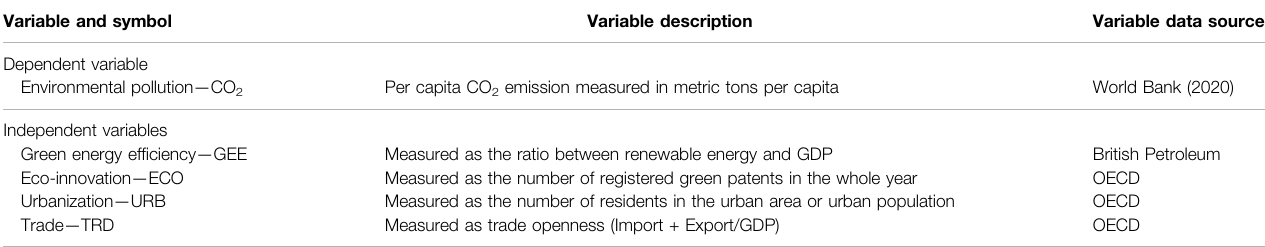
TABLE 1 | Variable description.